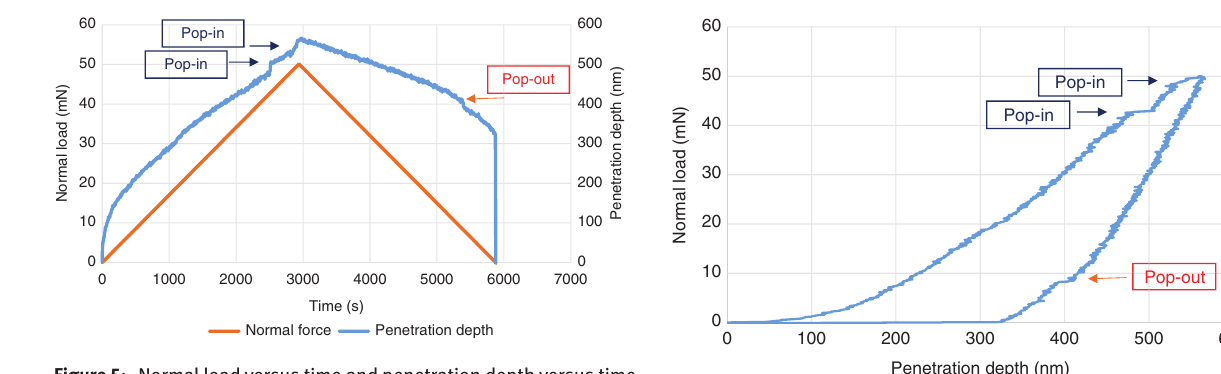
Figure 5: Normal load versus time and penetration depth versus time curves of silicon wafer for low loading/unloading rate (1 mN/min).